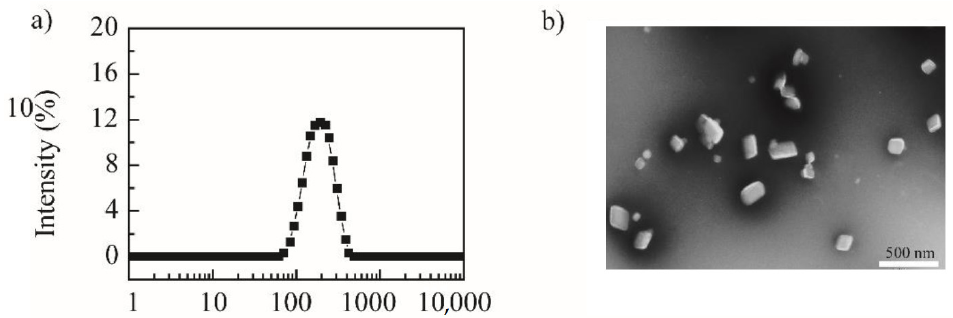
Figure 1. Particle size distribution curve ( a ) and TEM image of NRG-NSps ( b ) (scale bar: 500 nm).